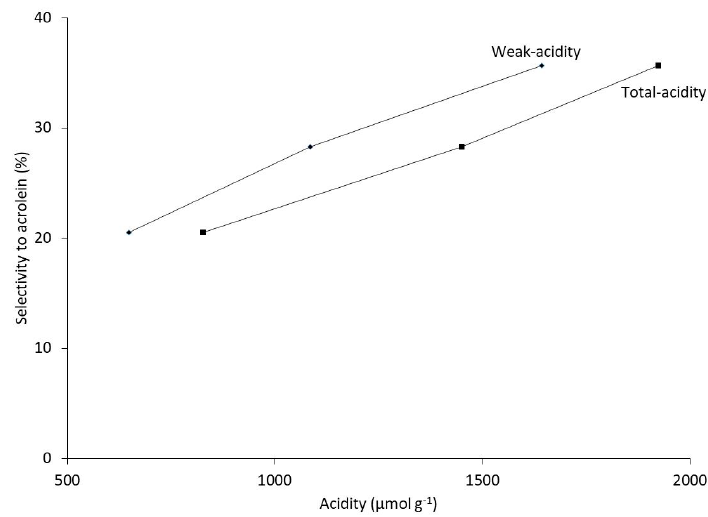
Figure 4. Variation in the selectivity to acrolein with acidity of P ̶ ZSM-5_280 after 5 h of liquid-phase dehydration of glycerol at 280 °C and a catalyst/sulfolane/glycerol mass ratio of 0.05/3/1.